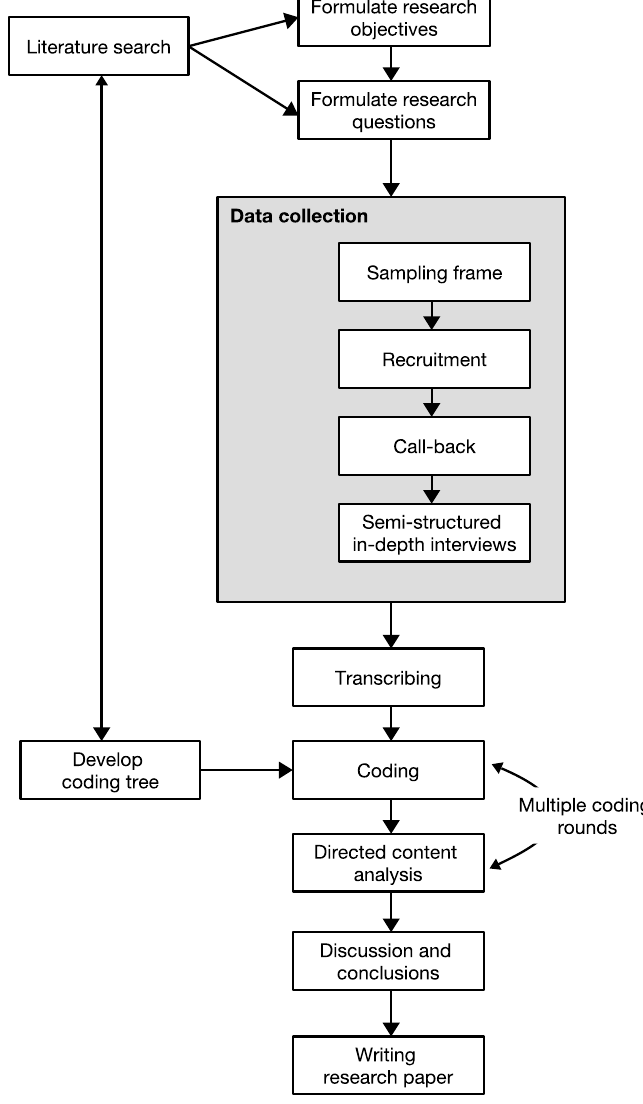
Figure 1. Research methodology diagram.